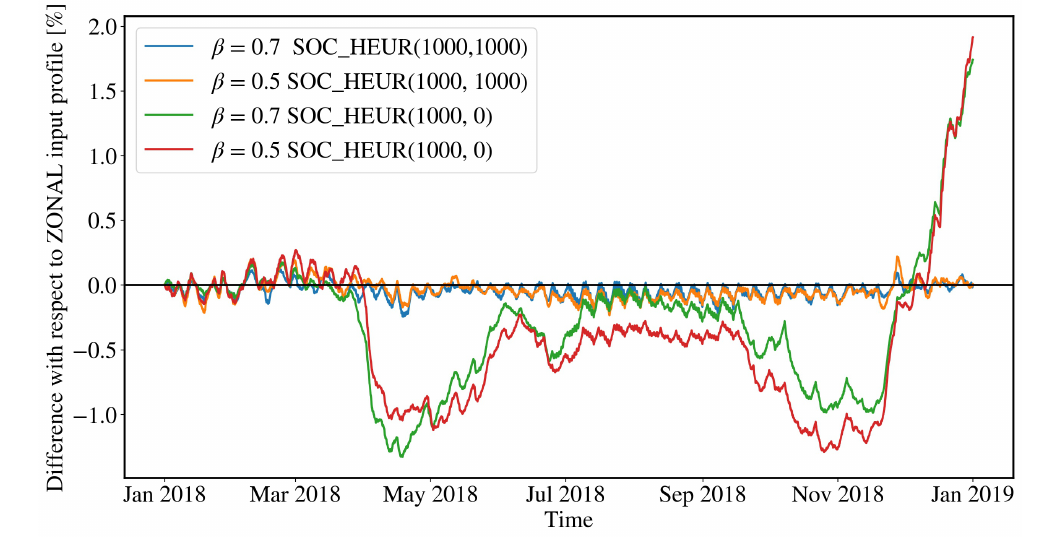
Figure 7. Aggregated SOC profile difference between the ZONAL input profile of Stage 1 and SOC _ HEUR ( 1000,1000 ) and SOC _ HEUR ( 1000,0 ) , respectively, in % with respect to the ZONAL